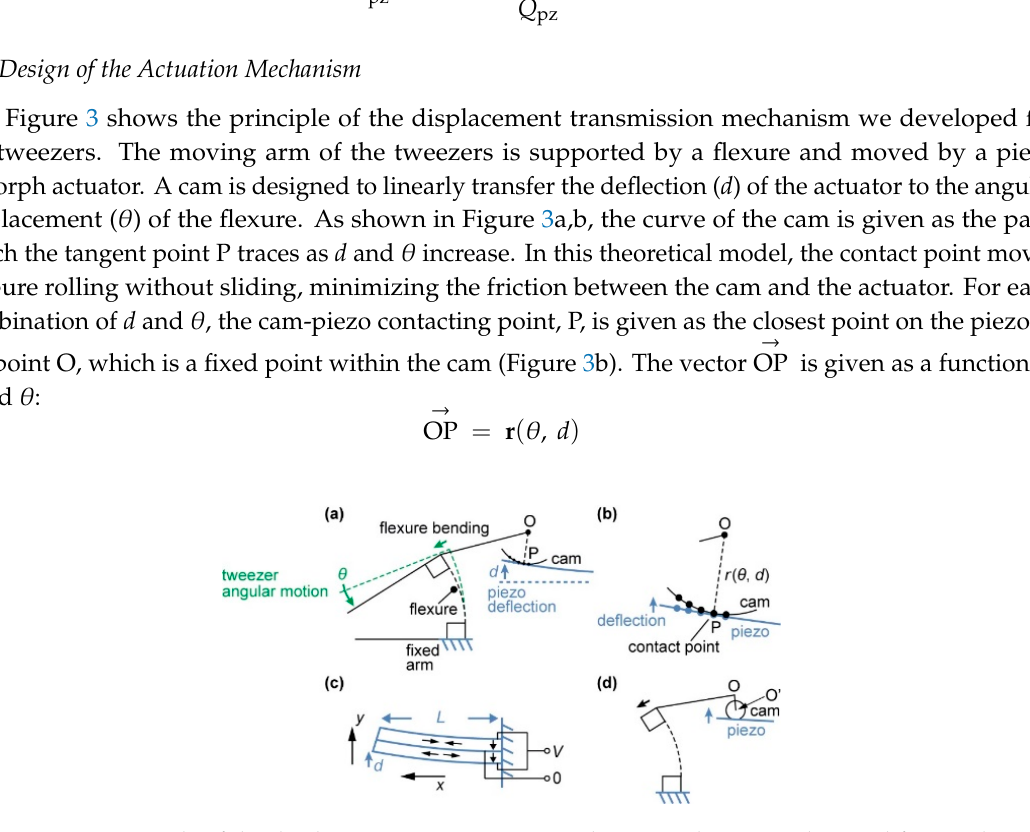
Figure 3. Principle of the displacement transmission mechanism. The cam is designed for θ to be linearly correlated to d . ( a ) The moving arm of the tweezers is supported by a flexure and actuated by a piezo bimorph actuator. ( b ) The curve of the cam is given as a path traced by the point of contact. ( c ) Piezo bimorph actuator works in a similar way to a bimetal cantilever ( d ) The cam is approximated as a circle in the actual 3D design (see supplementary Video S1).